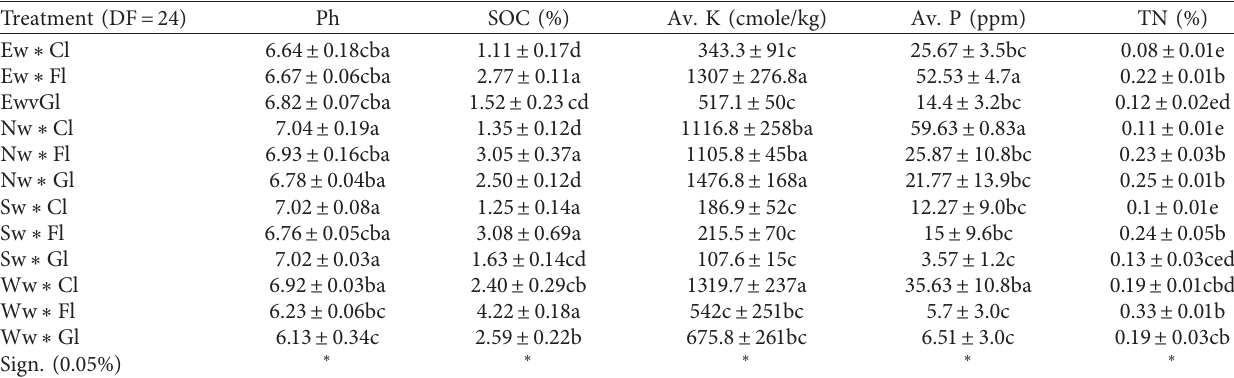
Table 4: Interaction effect of slope aspect and LU on SOC and primary macroessential